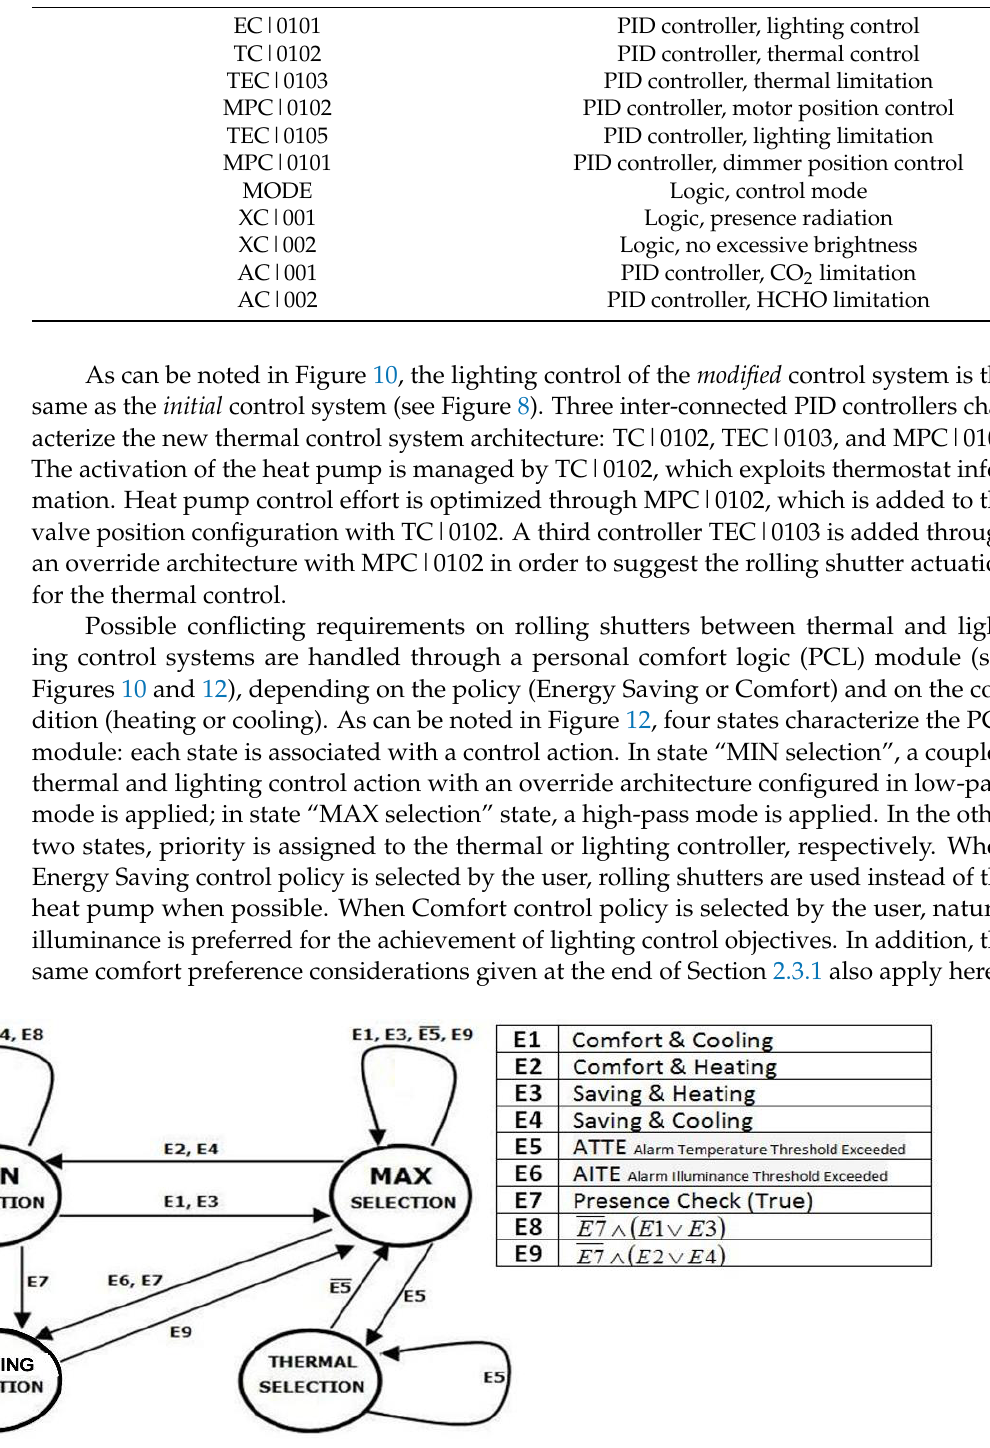
Table 11. Functional blocks description ( modified control system).